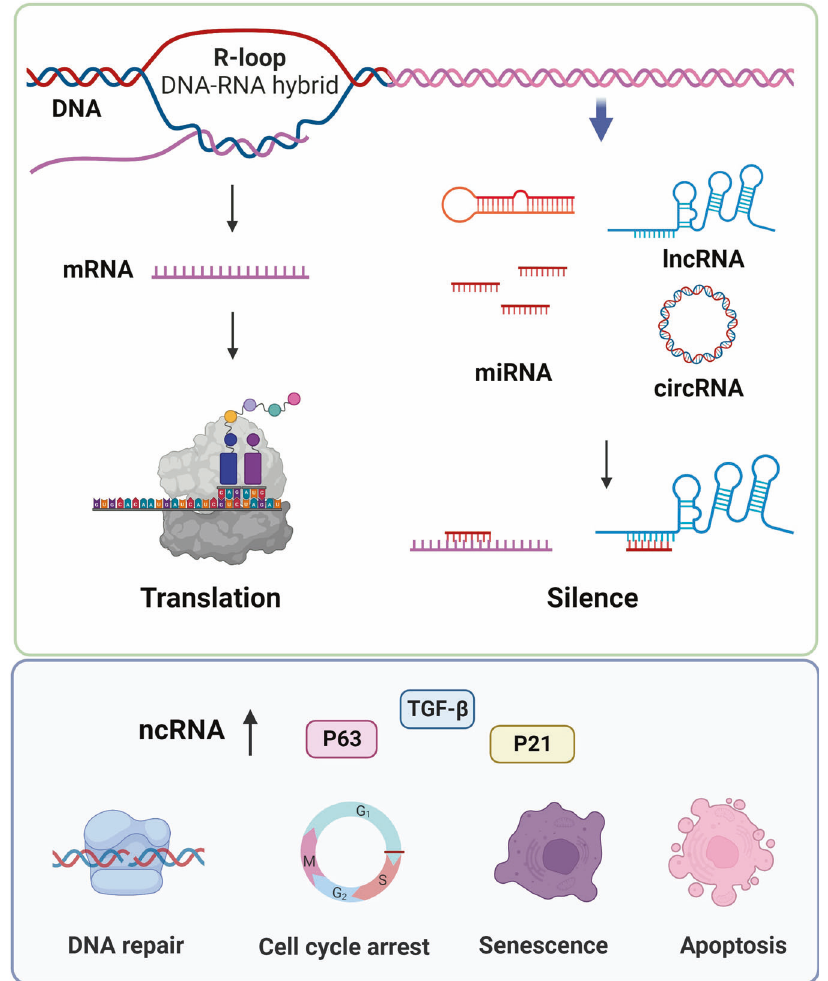
Fig. 6 The mechanism of non-coding RNAs regulation during aging. Non-coding RNAs (ncRNAs) include microRNAs (miRNAs), long non- coding RNAs (lncRNAs), R-loop (DNA-RNA hybrids), and circular RNAs (circRNAs). miRNAs bind to mRNAs, lncRNAs or circRNAs to prevent their functions Signal Transduction and Targeted Therapy (2022)